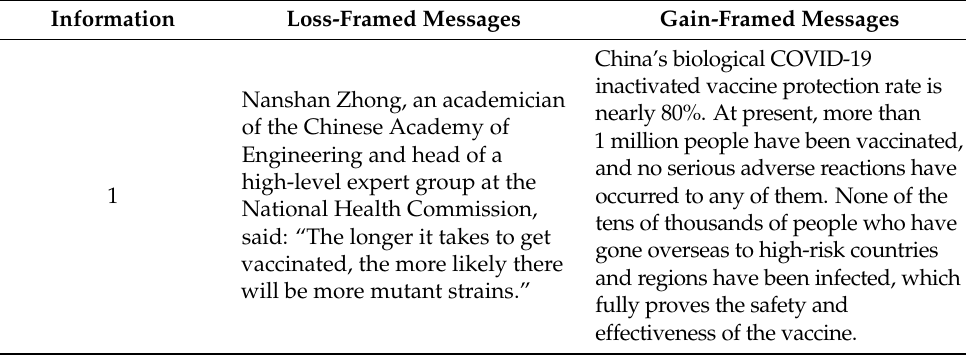
Table 1. Stimulation information used in the